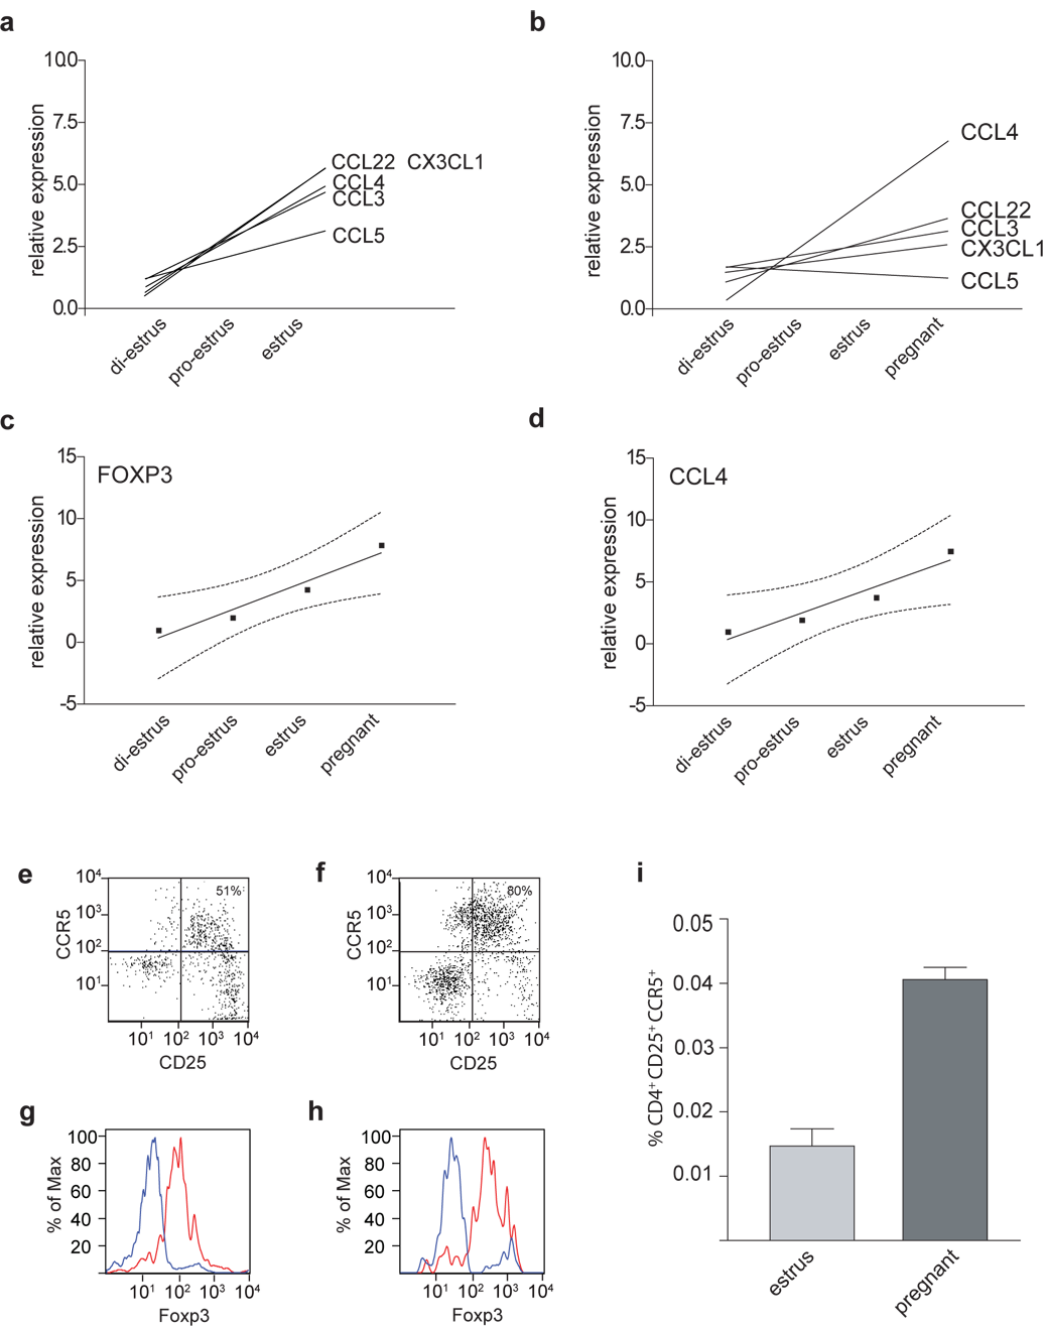
Figure 3. Chemokine fluctuation approaching estrus and pregnancy. Linear trends for the fluctuation of chemokine expression levels (same sample set used in Figs. 1 and 2) during (a) the phases approaching estrus (diestrus . pro-estrus . estrus) and (b) the phases approaching estrus and pregnancy. (c,d) : Linear trends for the fluctuation of (c) Foxp3 and (d) CCL4 expression levels during the phases approaching estrus and pregnancy. Dots represent the mean of each data set. Dotted curves represent the 95% confidence interval of the trend line. (e–i ) CCR5 + regulatory T cells in the uterus of mice at estrus or at mid-gestation. n=3 for estrus, each sample pooled from 3 mice; n=5 for pregnant, one mouse per sample. Uterine cells were isolated from C57BL/6 mice (e,g) at estrus or (f,h) at E10.5 (mid-gestation) after allogeneic mating and analyzed by FACS for the expression of (e,f) CD4, CD25 and CCR5 or (g,h) CD4, CD25 and Foxp3. (e,f) Plots show CD25 and CCR5 surface expression for all CD4 + gated cells. Number in top right corner denotes the percentage of CCR5 + cells amongst CD4 + CD25 + cells. 1 6 10 6 ‘total’ uterine cells collected; all CD4 + cells shown. (g,h) Histograms show intracellular Foxp3 stain in (red) CD4 + CD25 + or (blue) CD4 + CD25 2 cells. Representative samples are shown. (i) Uterine cells from C57BL/6 mice at estrus or at E10.5 of allogeneic pregnancy were analyzed by FACS. The percentage of CD4 + CD25 + CCR5 + cells amongst all uterine cells is shown.